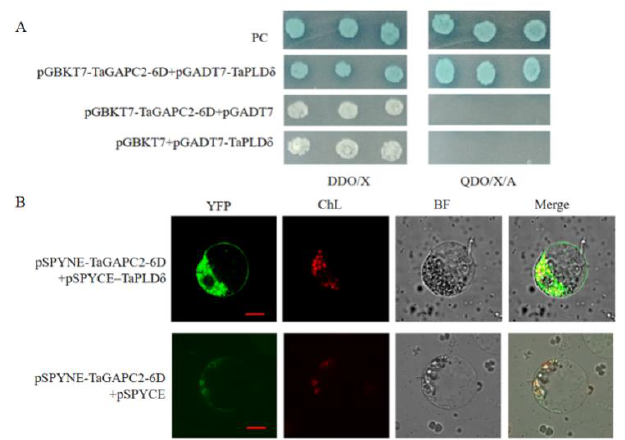
Figure 12. Identification of TaPLDδ interacting with TaGAPC2-6D. ( A ) Confirmation of true positive clones by small-scale yeast two-hybrid (Y2H) assay. SD/-Leu/-Trp/X-α-Gal (DDO/X), SD/-Leu/-Trp/X-α-Gal; SD/-Ade/-His/-Leu/-Trp/X-α-Gal/AbA (QDO/X/A), SD/-Ade/-His/-Leu/-Trp/X-α-Gal/AbA. PC indicates a positive control. ( B ) Bimolecular fluorescence complementation assay (BiFC) assay of the interaction between TaPLDδ and TaGAPC2-6D protein in tobacco leaf protoplasts. The pSPYNE-TaGAPC2-6D and pSPYCE-TaPLDδ constructs were co-infiltrated into tobacco by Agrobacterium. YFP fluorescence was detected by confocal laser scanning microscopy. Co-transformants of pSPYNE-TaGAPC2-6D and pSPYCE were used as negative controls. Scalebar = 100 µ